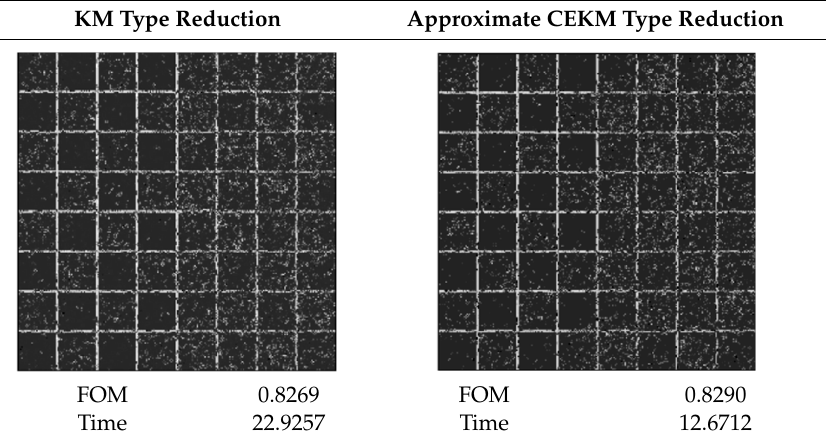
Table 15. Edge detection comparison with respect to classical KM type